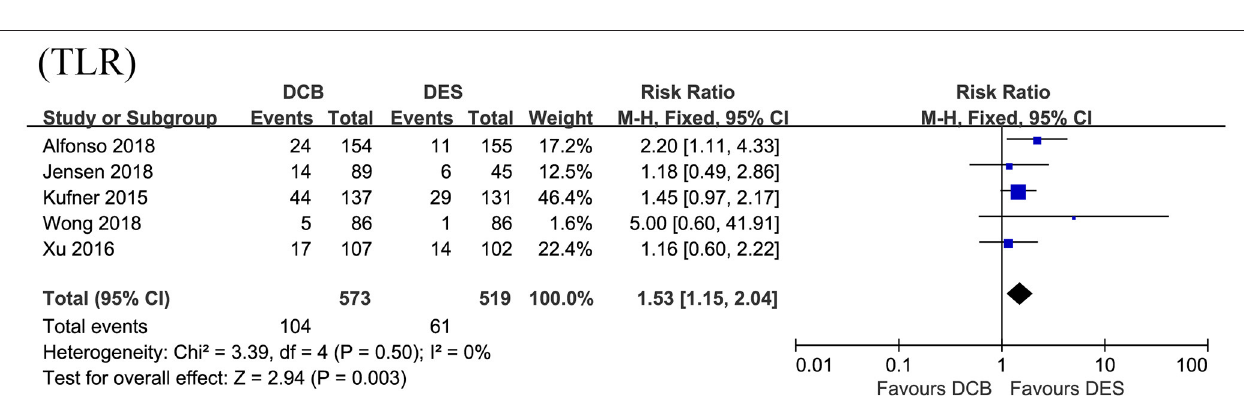
FIGURE 3 | Forest plot of comparing the risk of TLR between repeat DES implantation and DCB angioplasty. TLR, target lesion revascularization; DES, drug-eluting stents; DCB, drug-coated